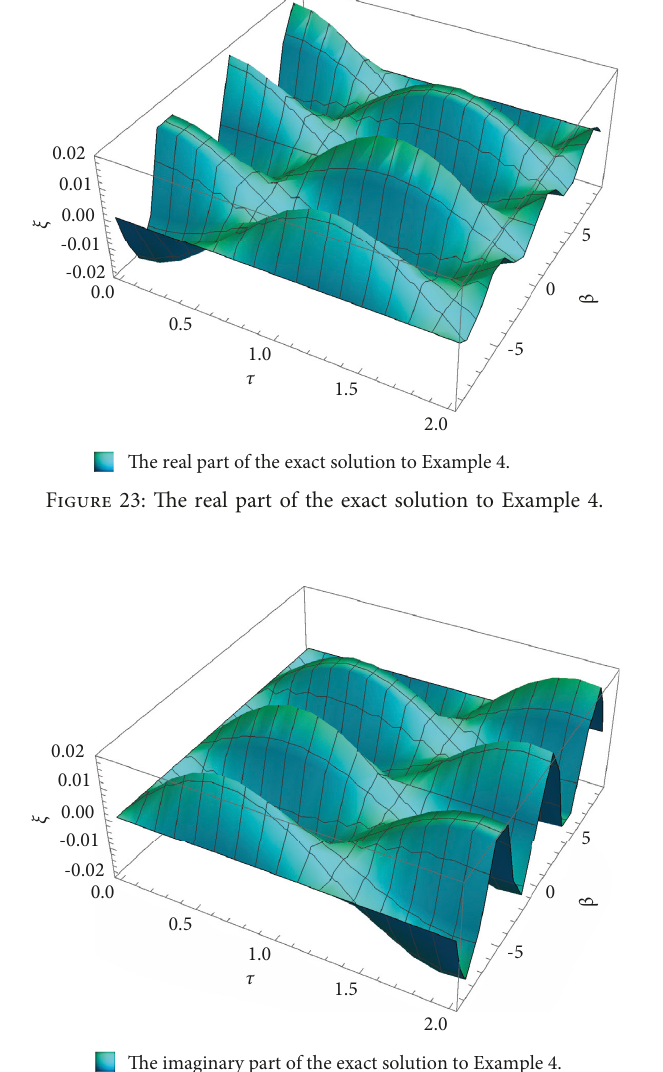
Figure 24: The imaginary part of the exact solution to Example